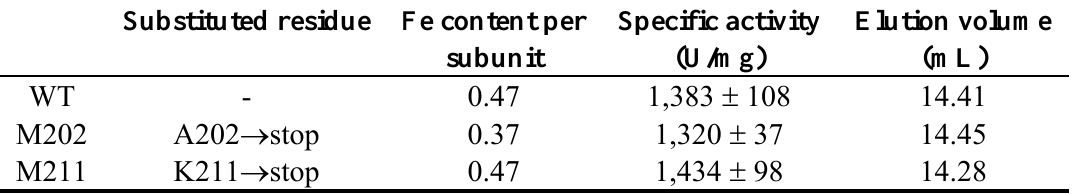
Figure 2. Characterization of the M211 and M202 mutants by SDS-PAGE (A), far-UV CD (B), intrinsic Trp fluorescence (C) and ANS fluorescence (D) spectra. The proteins were dissolved in 20 mM phosphate buffer, pH 7.4, with a final concentration of 0.27